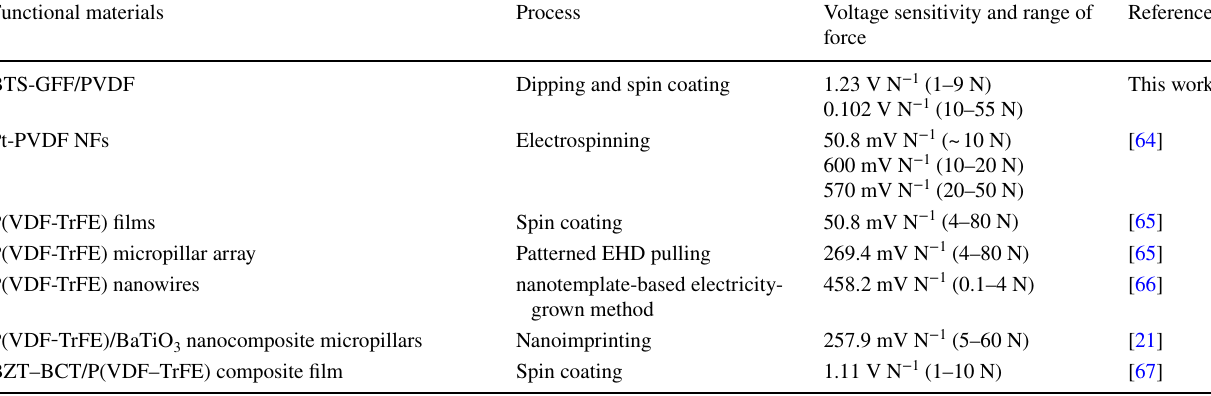
Table 1 Sensitivity comparison between BTS-GFF/PVDF sensors and other flexible piezoelectric sensors Functional materials